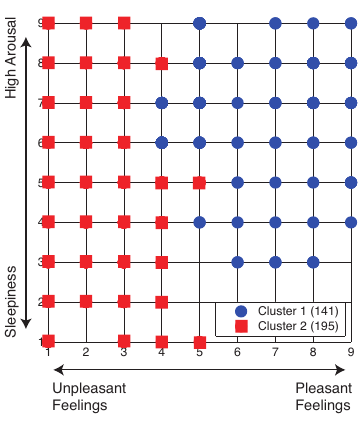
Figure 3. ERP comparisons between two clusters of Electrodes Fz, Cz and Oz, with a dotted line box indicating the time spans where there are significant differences between the two ERPs ( p < 0 : 05 )